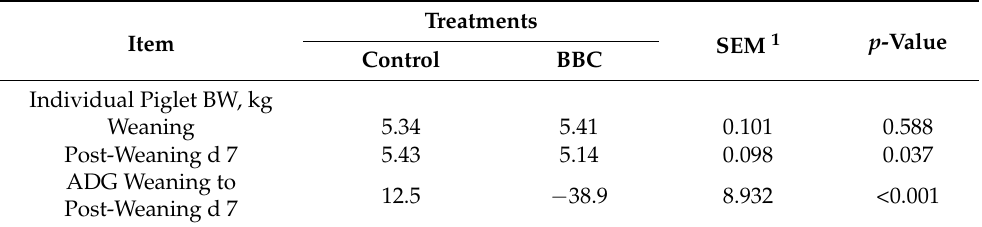
Figure 2. Relative concentration of botanical compounds in milk of hyperprolific sows supple- mented with dietary BBC. 1 Data are means of 12 sows per treatment (n = 12); 2 Difference in abundance/retention time of the BBC relative to assigned reference values (100%) in Control sows. Treatments: Control: unsupplemented diet; BBC: Control plus blend of botanical compounds. ND: not detected. (*) Indicate significant differences ( p < 0.05) using t -test. Table 5. Effects of supplemented BBC in prestarter diets on newly-weaned piglet’s growth perfor- mance (d 1 to